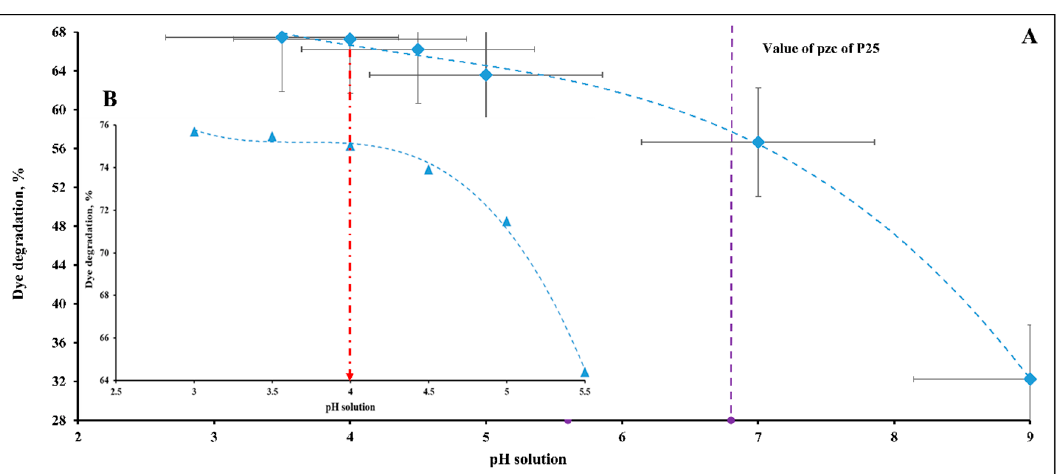
Figure 1. Behavior of DB15 degradation at different pH values with various dye concentrations: ( A ) Dye concentration 25 mg/L, ( B ) dye concentration 20 mg/L.